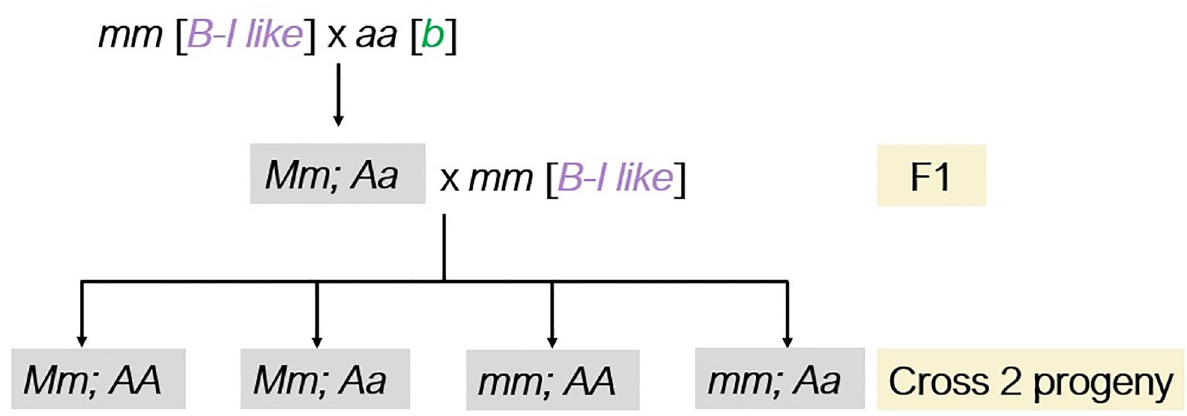
Fig 3. Crossing scheme used for a reverse genetic screen designed to investigate AGO104 contribution to paramutation. Alleles in genotype descriptions are as follows: M : mop1; m : mop1-1; A : ago104; a : ago104-5; b : neutral b1 allele; B-I like : epiallele from a mm plant. Pigmentation phenotypes are indicated in squared brackets.